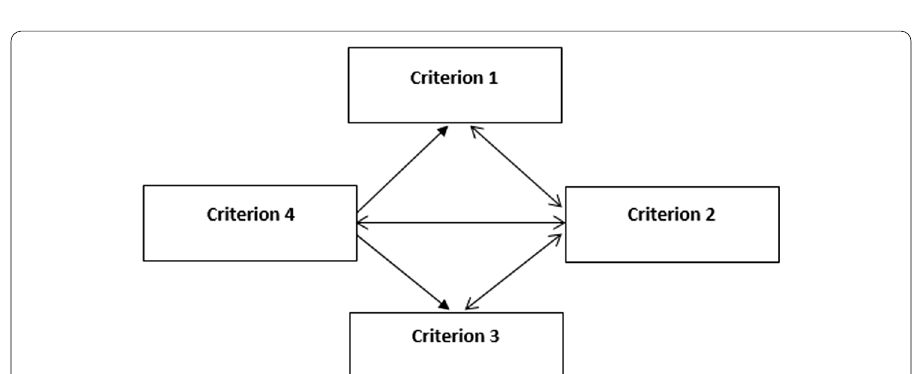
Fig. 3 Impact-relation directions of consensus-based multidimensional due diligence for revenue sharing